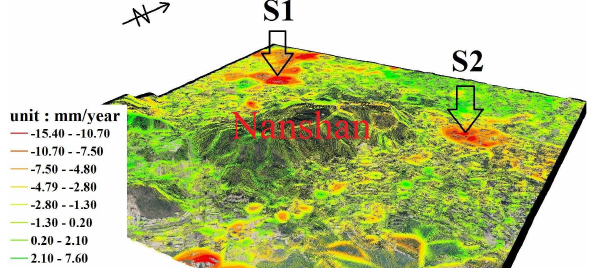
Figure 9. The subsidence model of the P2